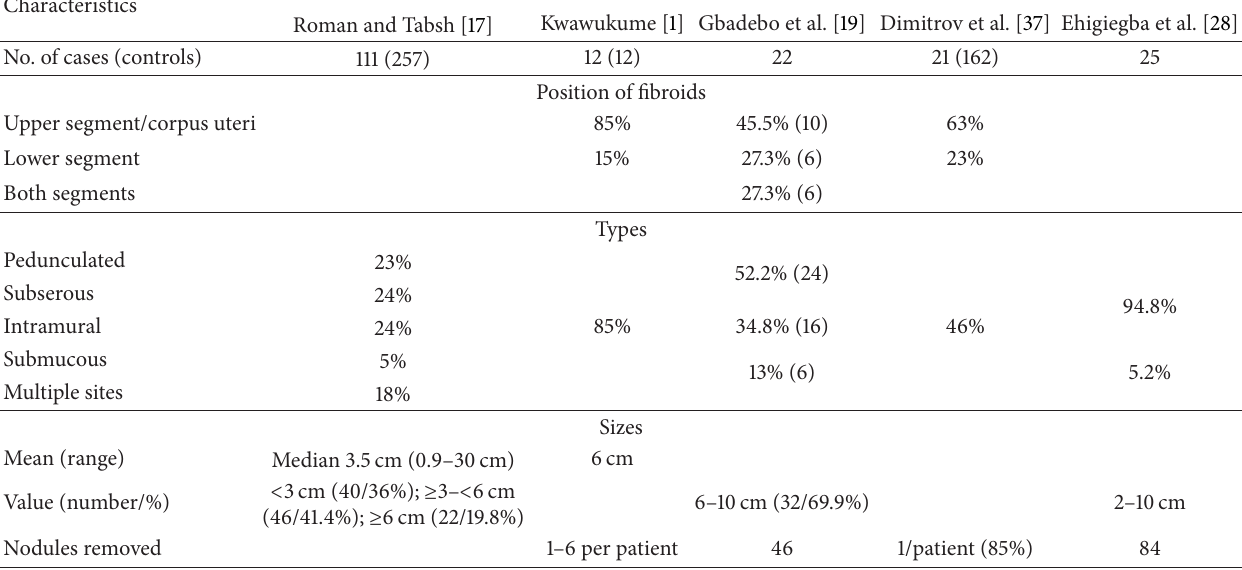
Characteristics